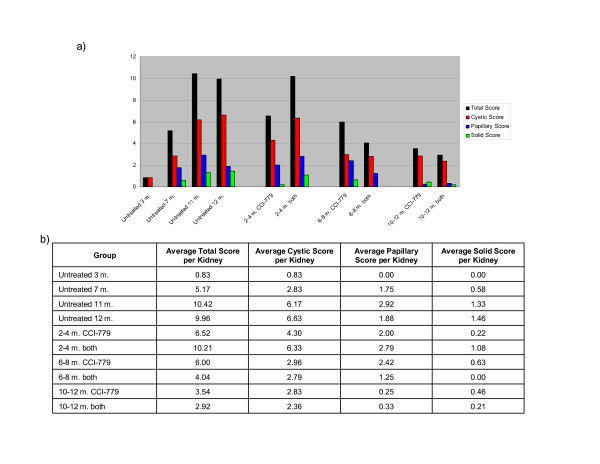
Kidney cystadenoma scores according to treatment cohort and lesion subtype (cystic, papillary, solid). Cystadenoma score for each subtype is based on number and size of each lesion as described in methods. a) Average scores are plotted according to treatment cohort in graphical format. b) Average total score per kidney and average score per kidney for each lesion subtype by cohort in table format. "Both" refers to a combination of CCI-779 and IFN-γ.